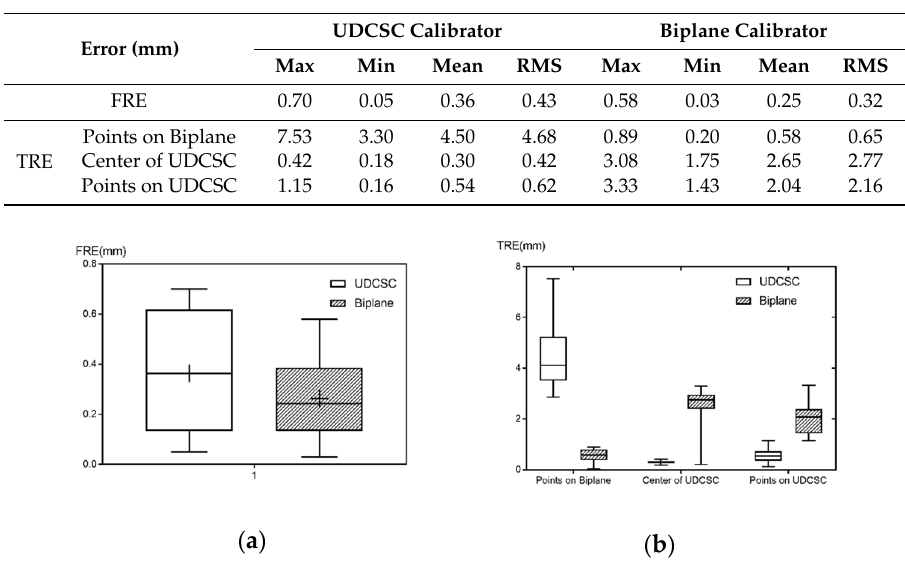
Table 1. Comparison of calibration accuracy of di ff erent calibrators.